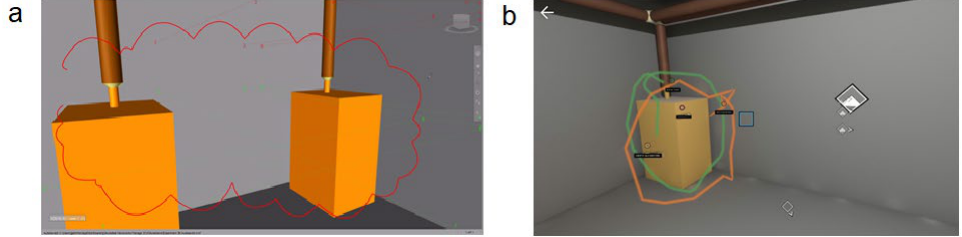
Figure 10. Teams creating markup during meetings in: ( a ) BIM platform; ( b ) VR platform.